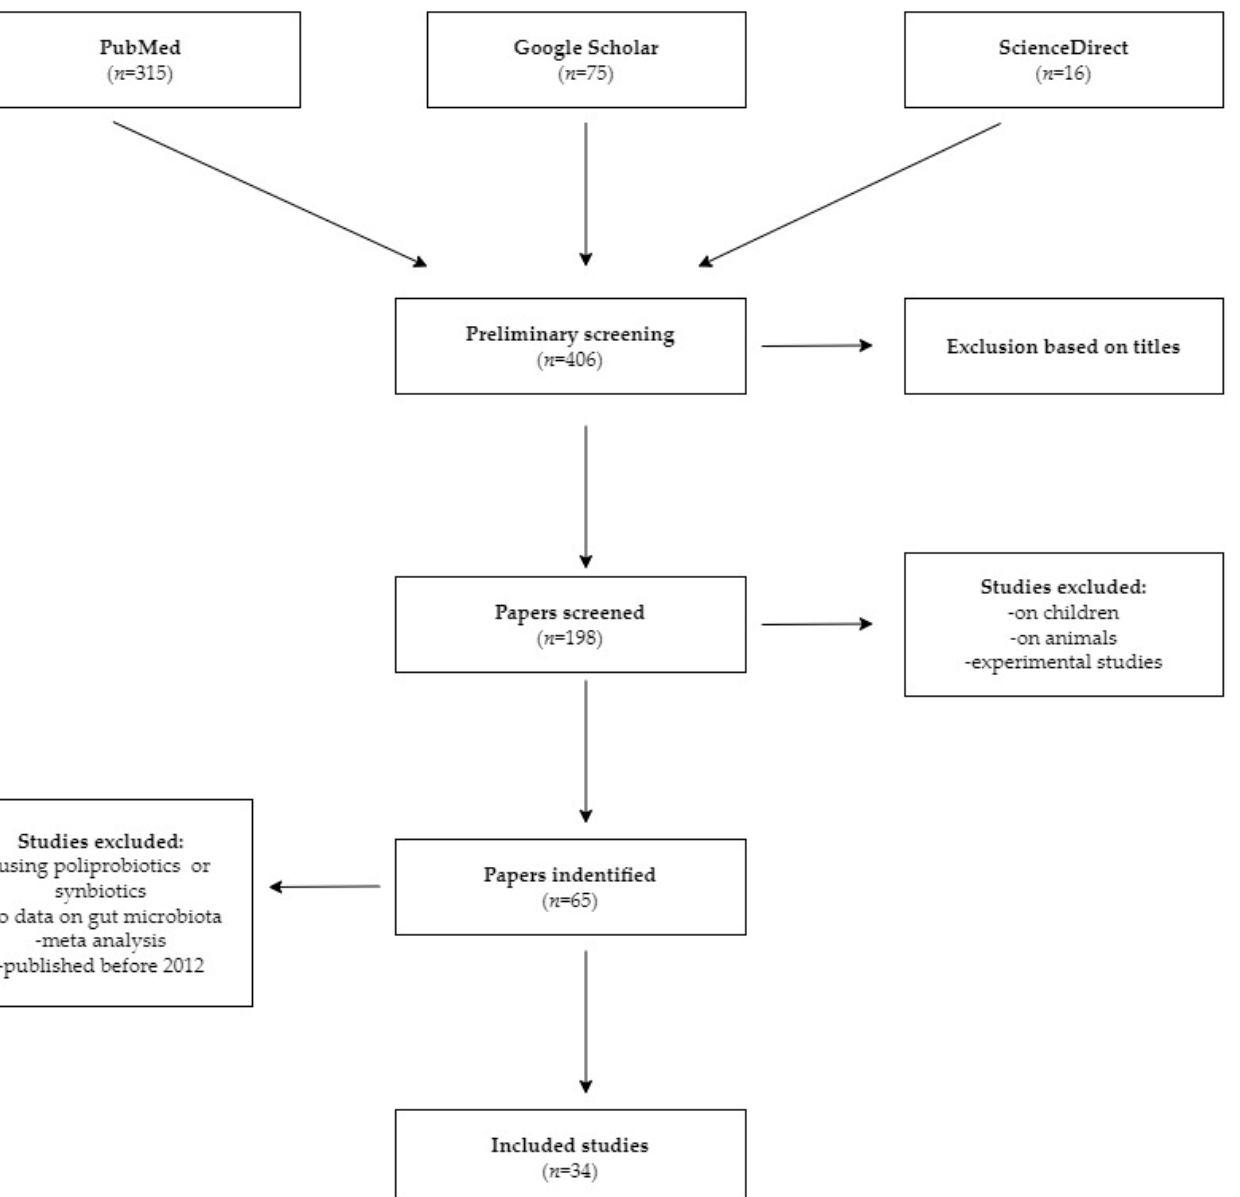
Figure 1. Flow diagram of the records included in the narrative review.